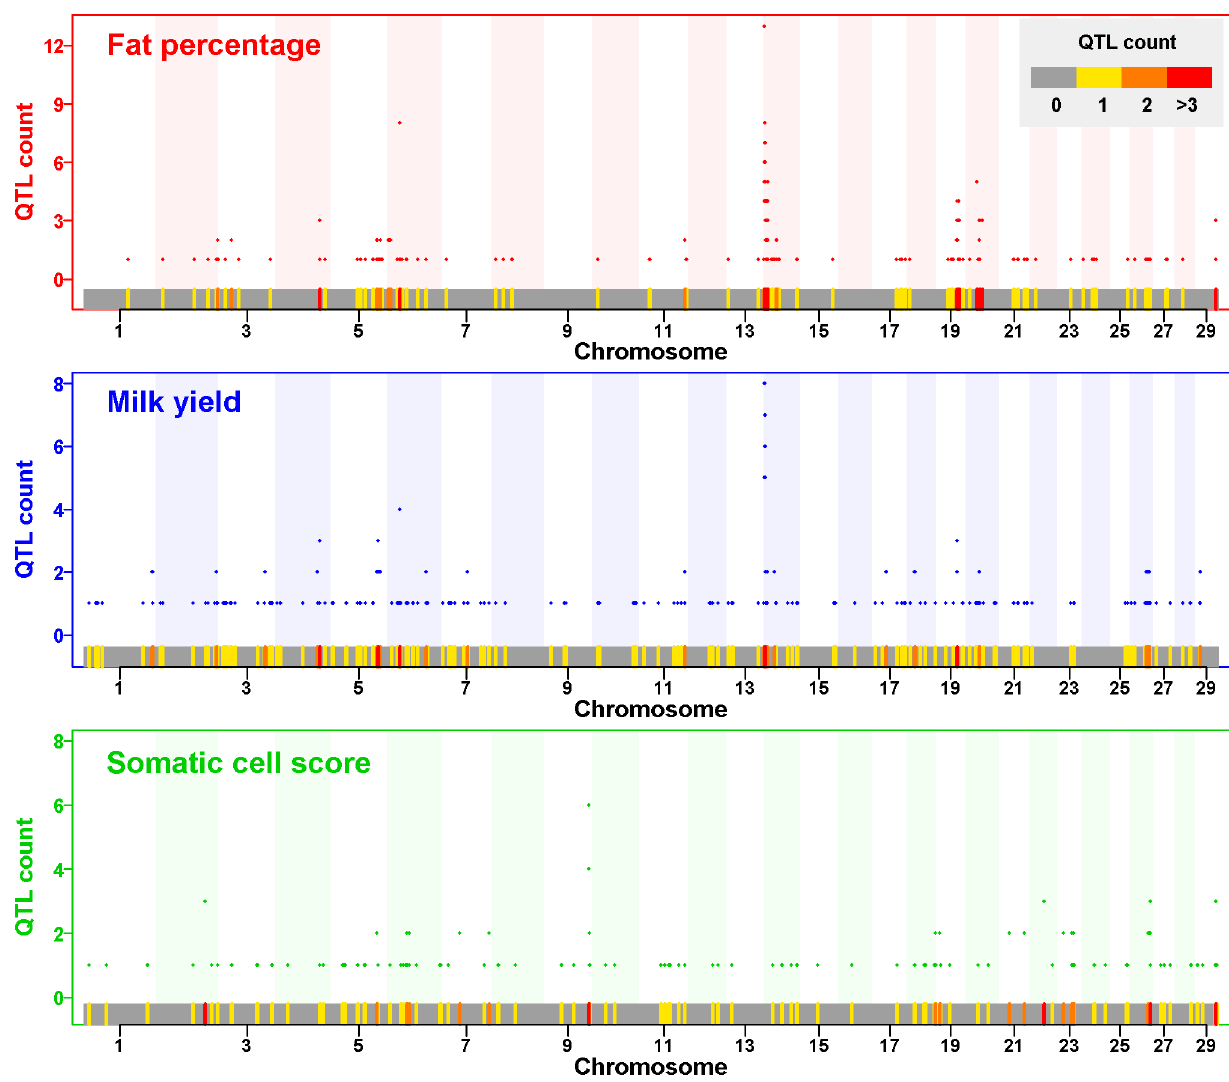
Figure 3. Distribution of reported QTLs positions and marker weights obtained from QTL list. Reported QTLs associated with fat percentage (red), milk yield (blue) and somatic cell score (green) retrieved from animalQTLdb (http://www.animalgenome.org/animlQTLdb) [17]. Marker weights were calculated as the number of times that each marker was reported to be within a significant QTL region (QTL counts). The colored bar under each plot shows the distribution of QTL positions across the whole genome for the three traits with color keys defined in the first plot (top-right).